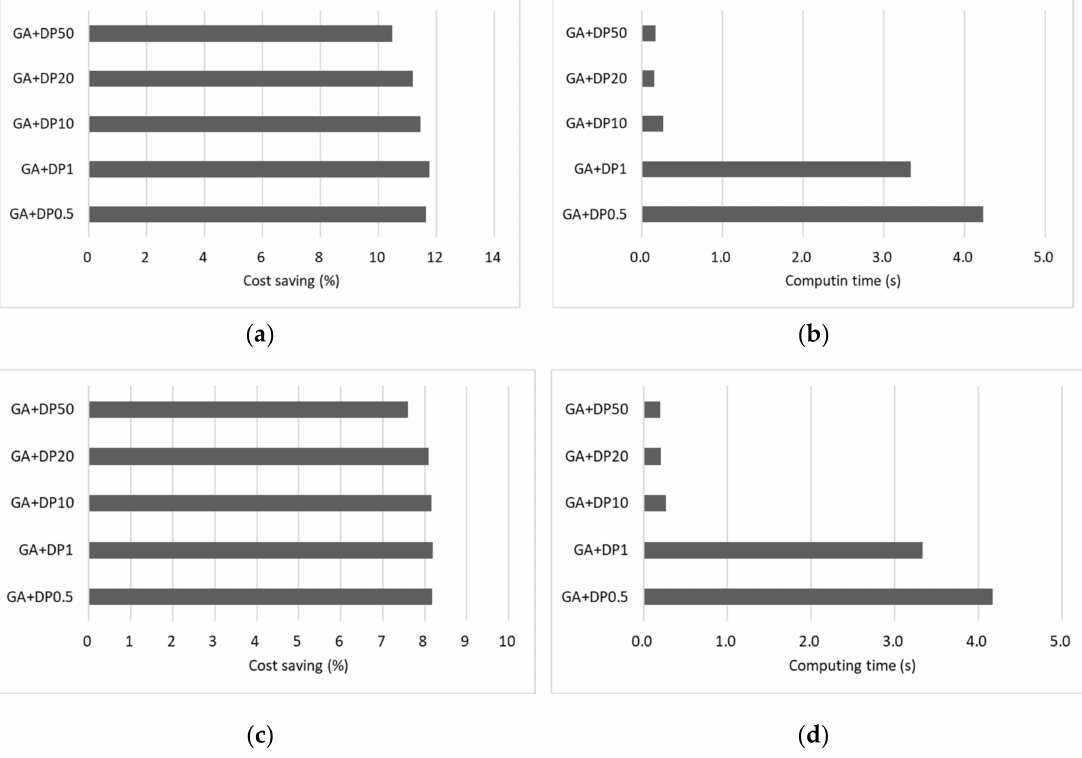
Figure 6. Performance of the combined methods of a genetic algorithm (GA) and dynamic programming (DP) with various sizes of base unit. ( a ) Average cost saving over all cases without demand charge; ( b ) average computing time over all cases without demand charge; ( c ) average cost saving over all cases with demand charge; ( d ) average computing time over all cases with demand